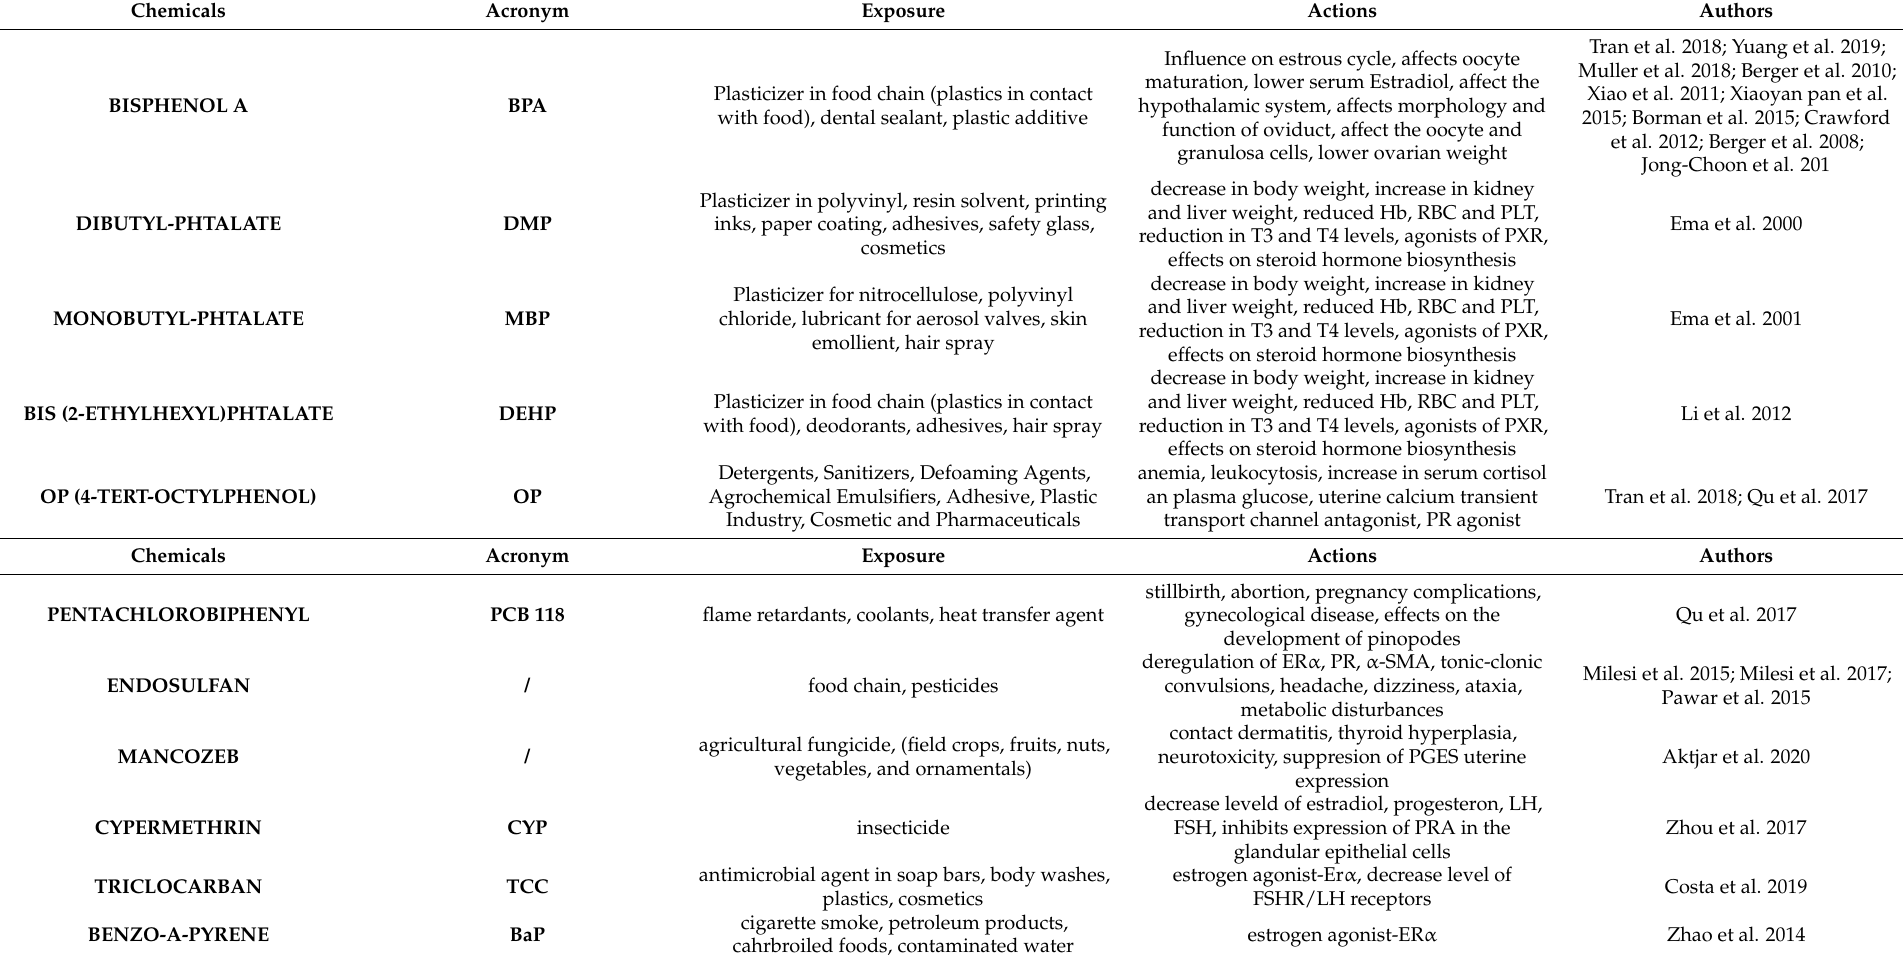
Table 1. EDCs and reproductive